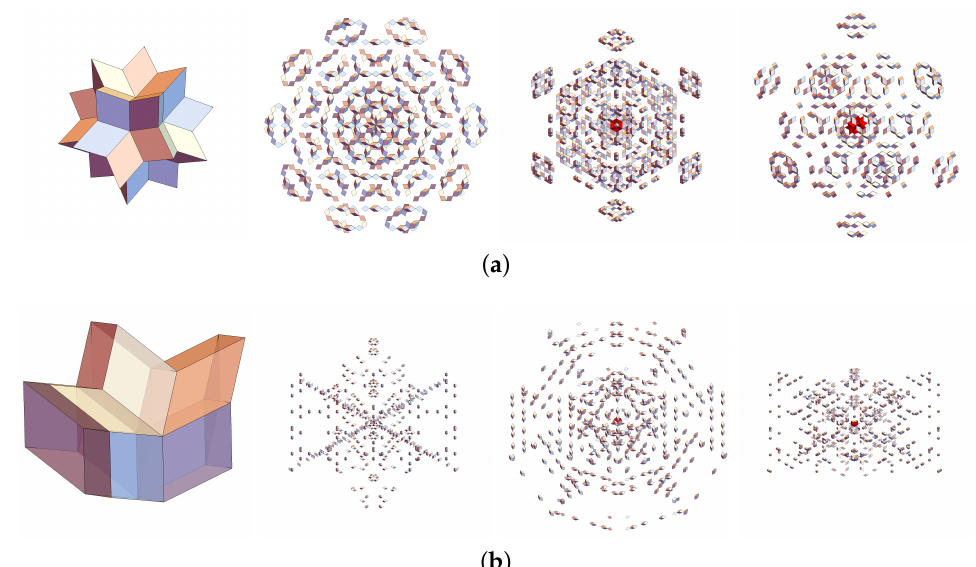
Figure 9. Vertex configurations and their empires for the Ammann tiling (projection Z 6 → E 3 ). The tiles of this quasicrystal are all rhombohedrons, and the vertex configurations are analogous to those of the Penrose tiling. The empires (shown in three orientations to the right the vertex configurations) vary in both structure and